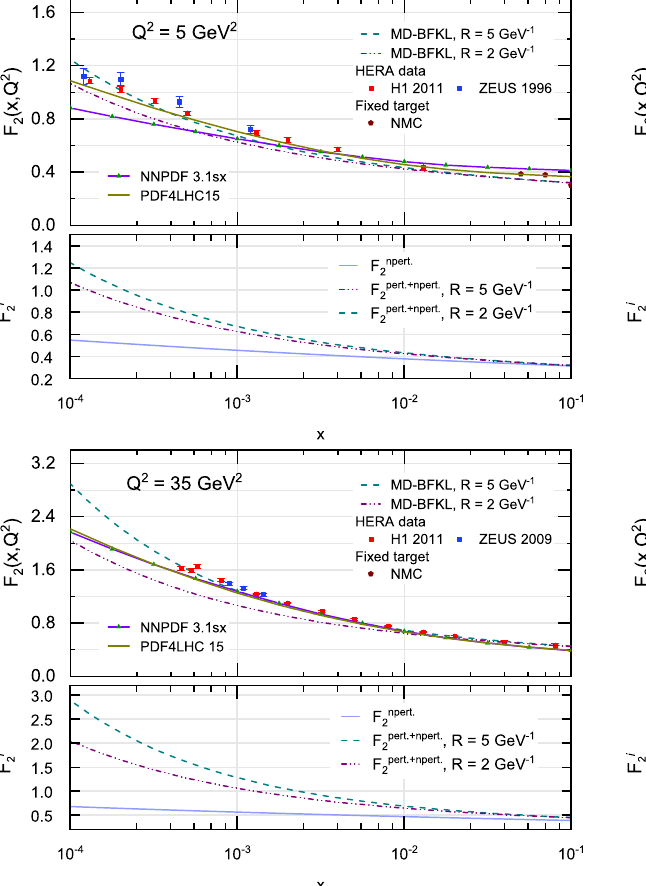
PDF4LHC 15 [54] is also included. The background contribution is ( x = 0 . 1 ) ≈ 0.316, 0.384, 0.391 and 0.406 given by (68) with F BG 0 2 corresponding to four Q 2 values viz. 5 GeV 2 , 15 GeV 2 , 35 GeV 2 and 45 GeV 2 . Separate plots of F npert. vs. F npert.+pert. is also 2 2